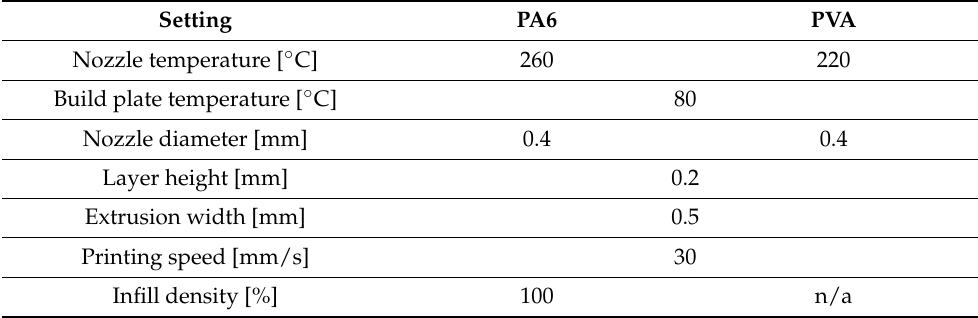
Table 1. FFF process parameters for specimen manufacturing. Setting PA6 PVA Nozzle temperature [ ◦ C] 260 220 Build plate temperature [ ◦ C] 80 Nozzle diameter [mm] 0.4 0.4 Layer height [mm] 0.2 Extrusion width [mm] 0.5 Printing speed [mm/s] 30 Infill density [%] 100 n/a During the solidification progress, four equiaxed microstructures, corresponding to fraction solid (f S ) varying from 0.61 up to 0.91, were selected, and scaled 3D samples were printed with a side length of 5 × 5 × 5 cm 3 . Seven polyamide samples (see Figure 3) for 4